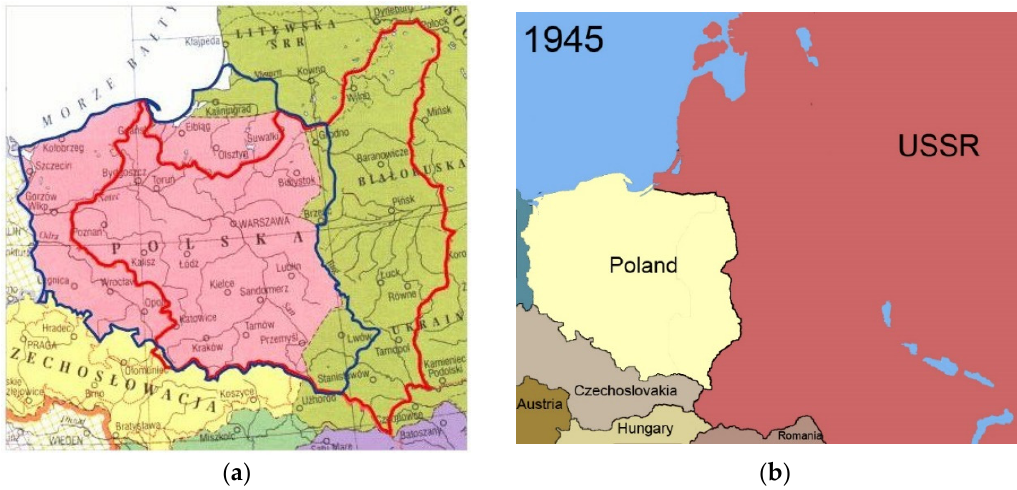
Figure 7. Map of Poland after 1945. Source: Narodowi Konserwaty ś ci.pl ( a ), Esemono (Public domain) Wikimedia Commons, the free media repository ( b ).